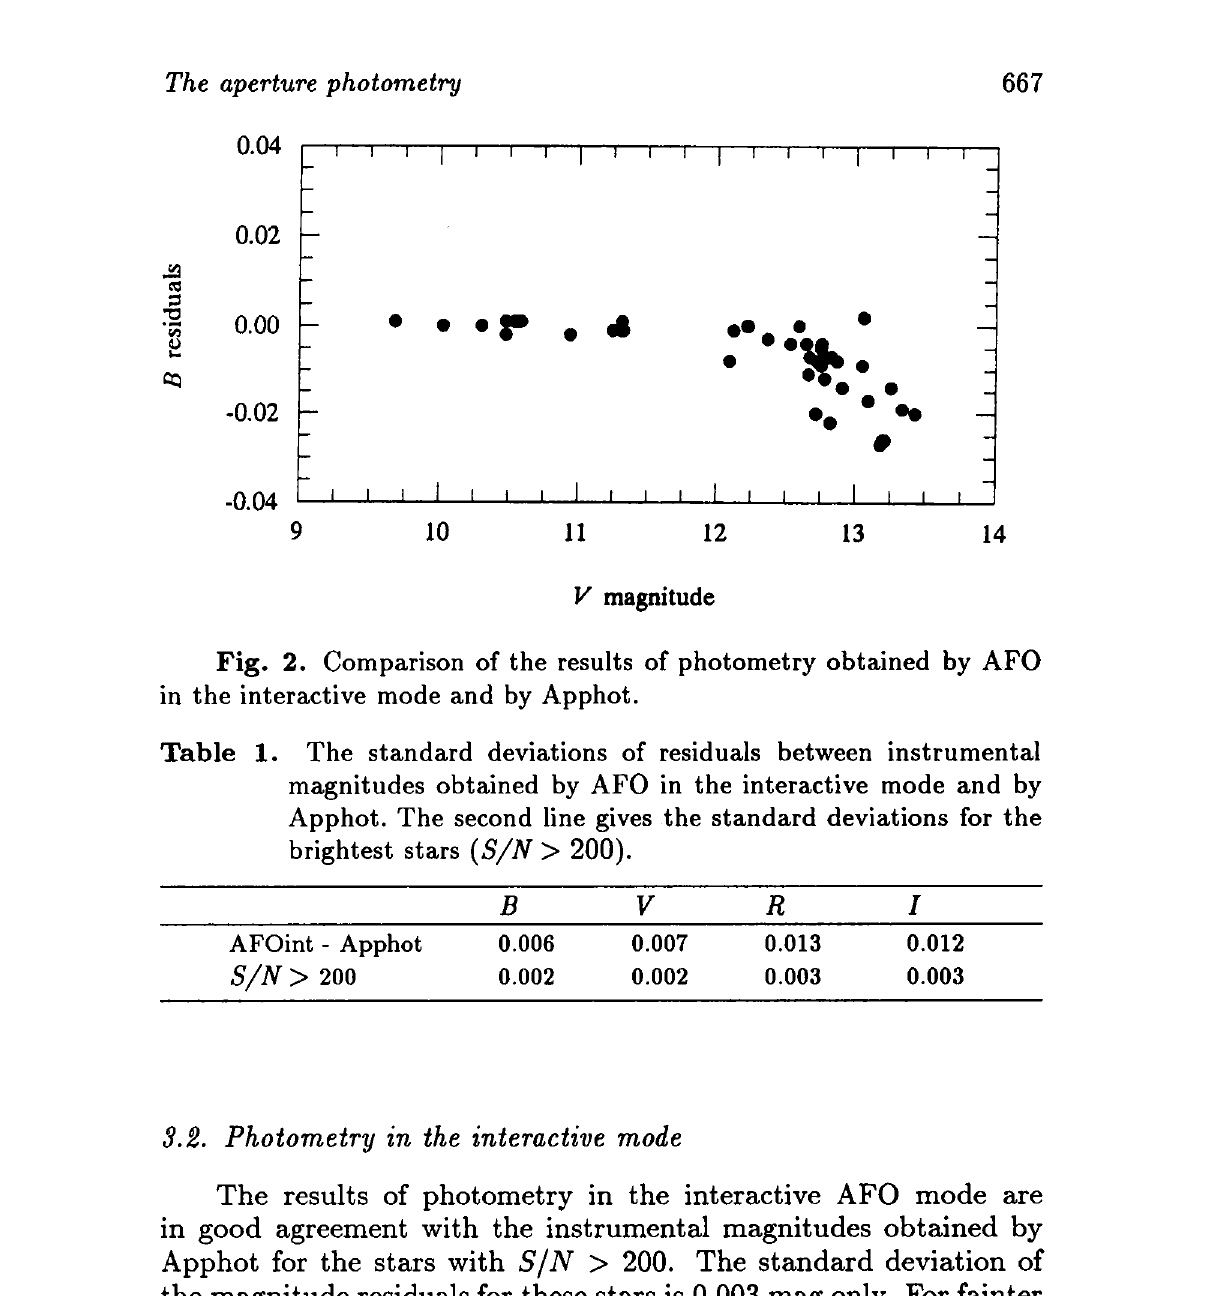
Fig. 2. Comparison of the results of photometry obtained by AFO in the interactive mode and by Apphot. The standard deviations of residuals between instrumental magnitudes obtained by AFO in the interactive mode and by Apphot. The second line gives the standard deviations for the brightest stars ( S /N >